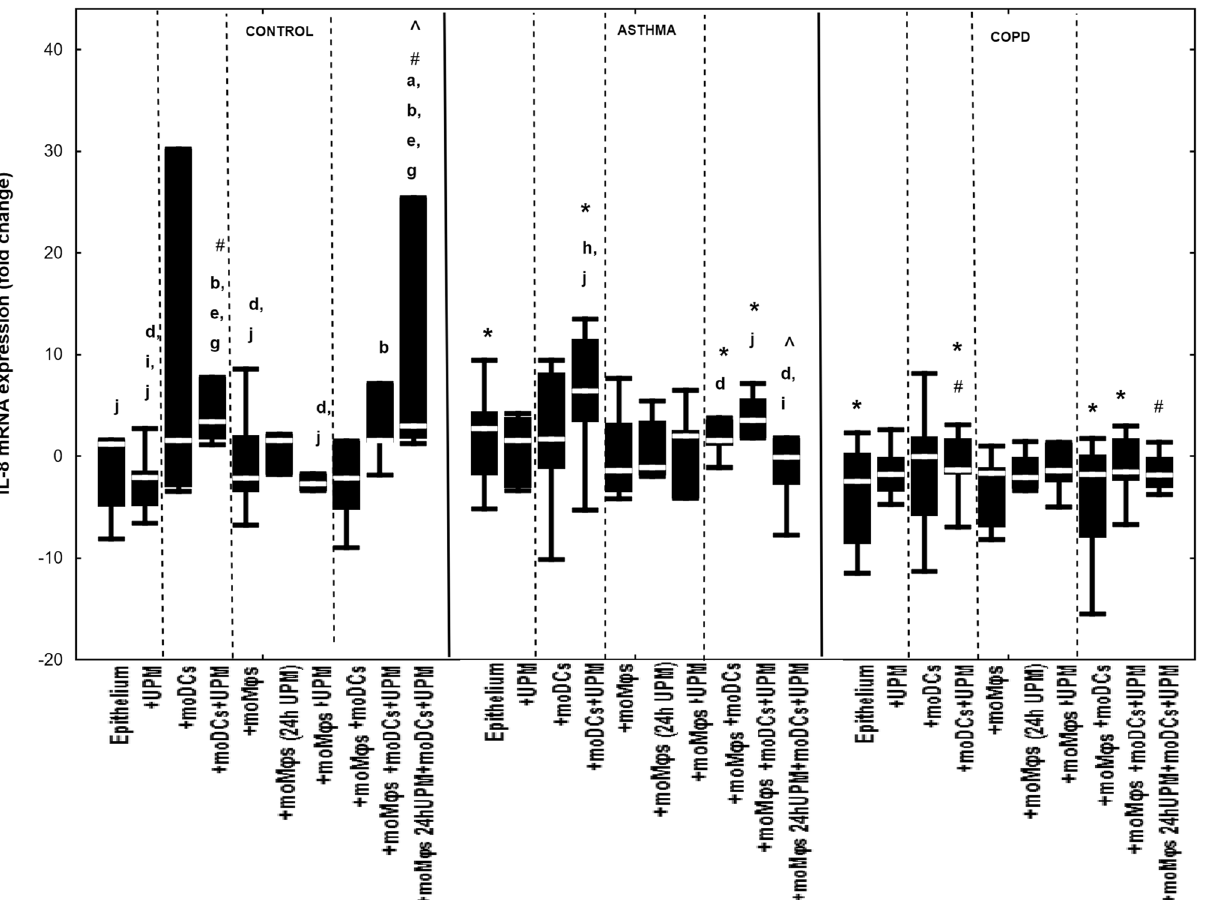
Figure 4. IL-8 mRNA expression in air–liquid interface (ALI) after 24 h UPM exposure in multi co-culture schemes in control subjects, asthma and COPD patients. The data are shown as non-outlier range (whiskers), interquartile range (box) and median (line); p value calculated using Mann–Whitney U test. The p value < 0.05 in comparison to: a—epithelium, b—epithelium + UPM, c—epithelium + moDCs, d—epithelium + moDCs + UPM, e—epithelium + moMφs, f—epithelium + moMφs (24 h UPM), g— epithelium + moMφs + UPM, h—epithelium + moMφs + moDCs, i—epithelium + moMφs + moDCs + UPM, j—epithelium + moMφs (24hUMP) + moDCs + UPM; ^ asthma versus control, # COPD versus control, *asthma versus